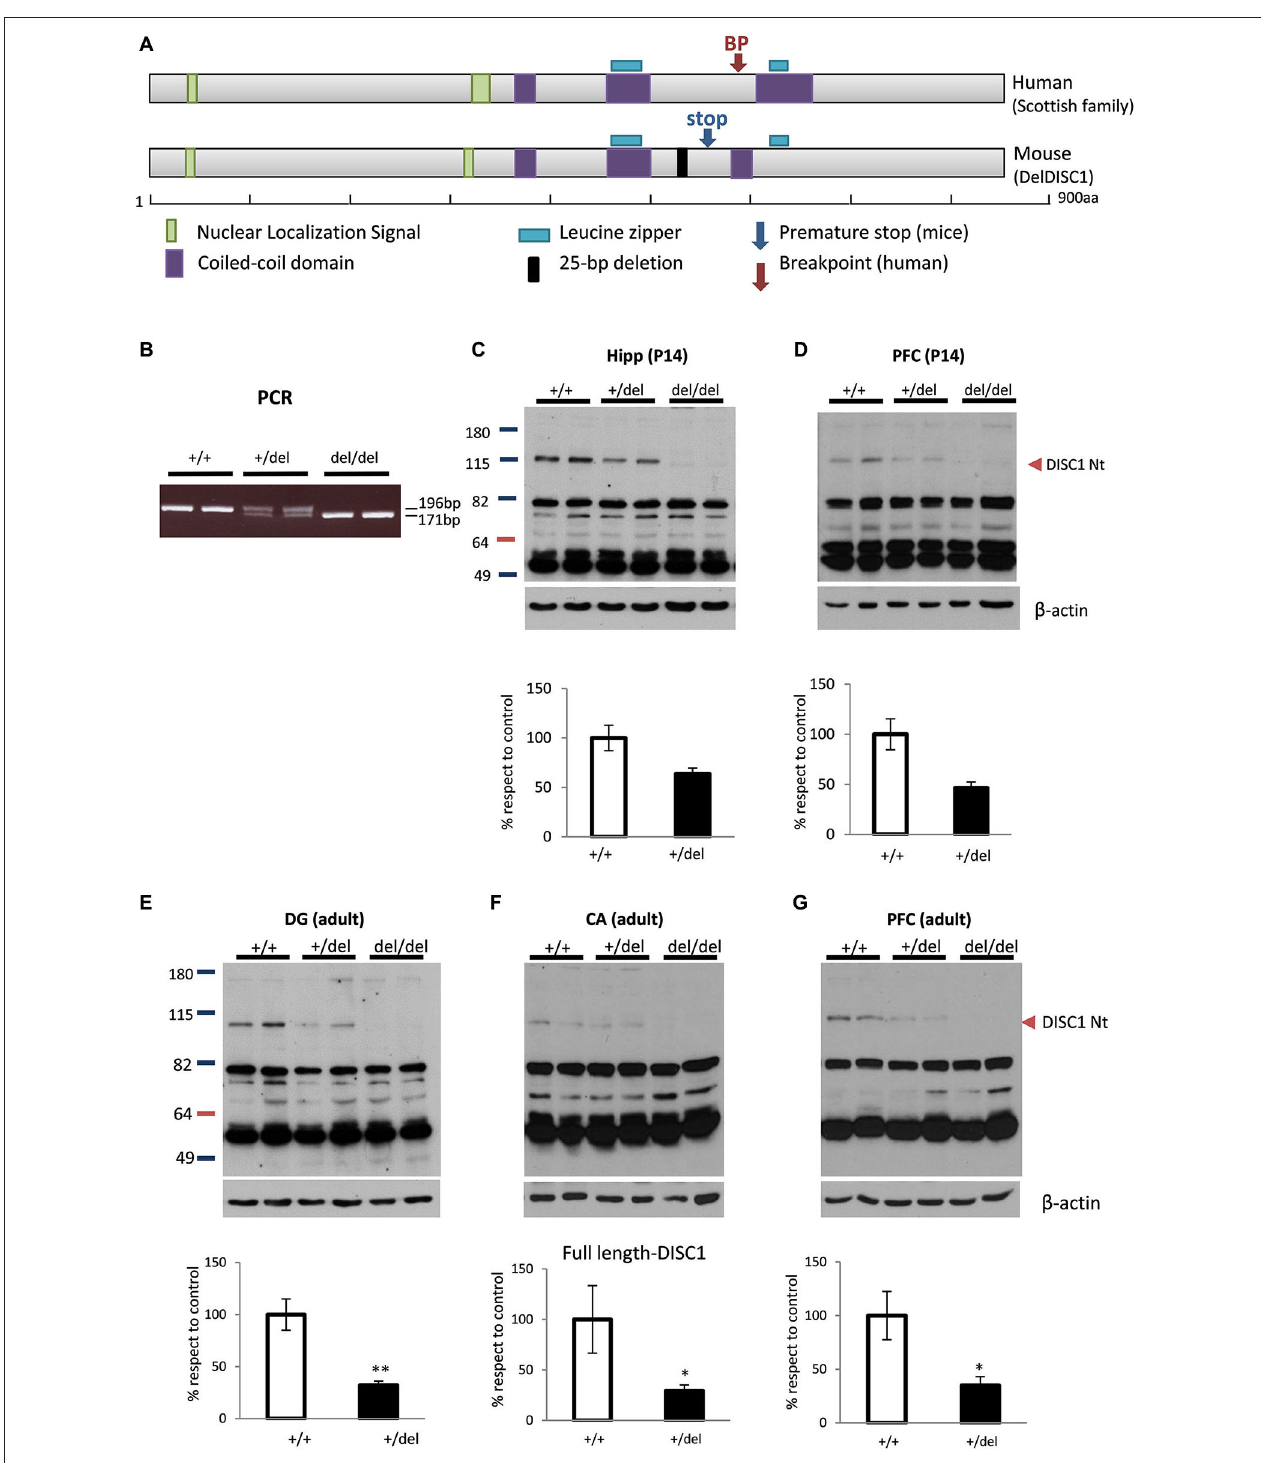
mutant disc1 gene in +/del and del/del mice. (C–G) Detection by Western blot and quantification of decreased levels (+/del) or absence (del/del) of full length DISC1 in hippocampus ( (C) , p = 0.058) or prefrontal cortex (PFC) ( (D) , p = 0.069) of P14 mice ( n + / + = 6, n + / del = 4, n del / del = 4) and dentate gyrus (E) , cornu Amonnis (F) or PFC (G) of adult mice ( n + / + = 4, n + / del = 6, n del / del = 4). * p < 0.05, ** p <